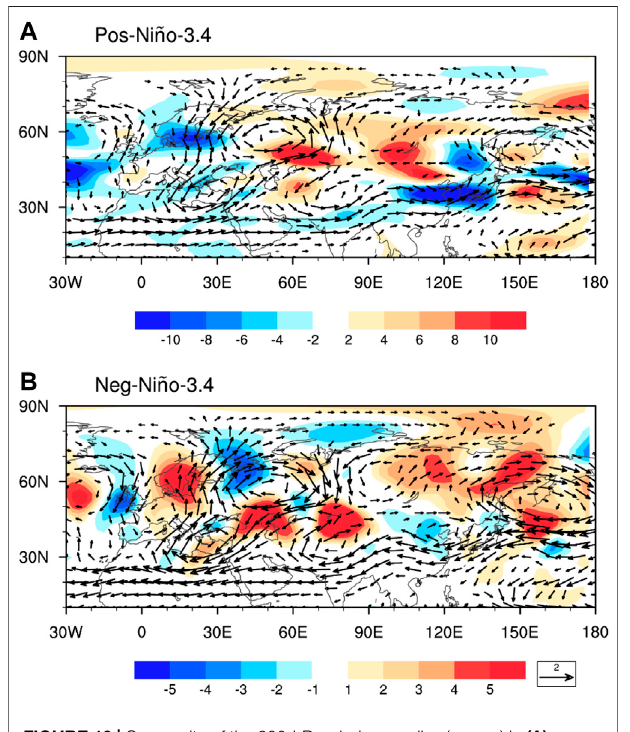
FIGURE 10 | Composite of the 200-hPa wind anomalies (arrows) in (A) positive and (B) negative Niño 3.4 summers (June-July-August). Difference in the interannual variance of the (A) 200-hPa zonal wind (shading) and (B) meridional wind (shading) between negative and positive Niño 3.4 summers(negativeminus positive). Note that thescale ofshading in (A) istwo times that in (B) . Unit: m/s.